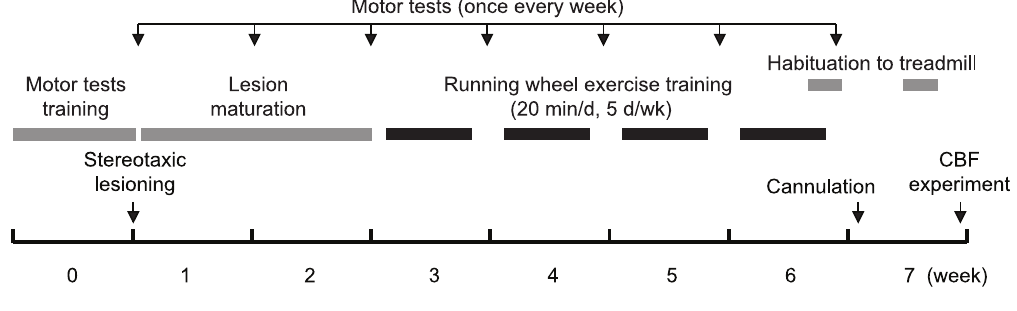
Figure 1. Timeline of experiments.